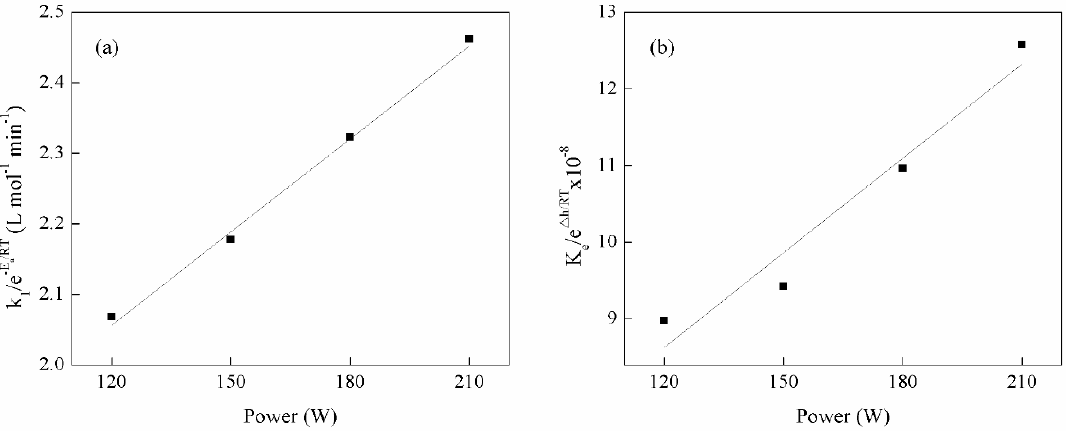
Table 3. Constants and power coefficients for describing the relationship between microwave power and pre-exponential factors.